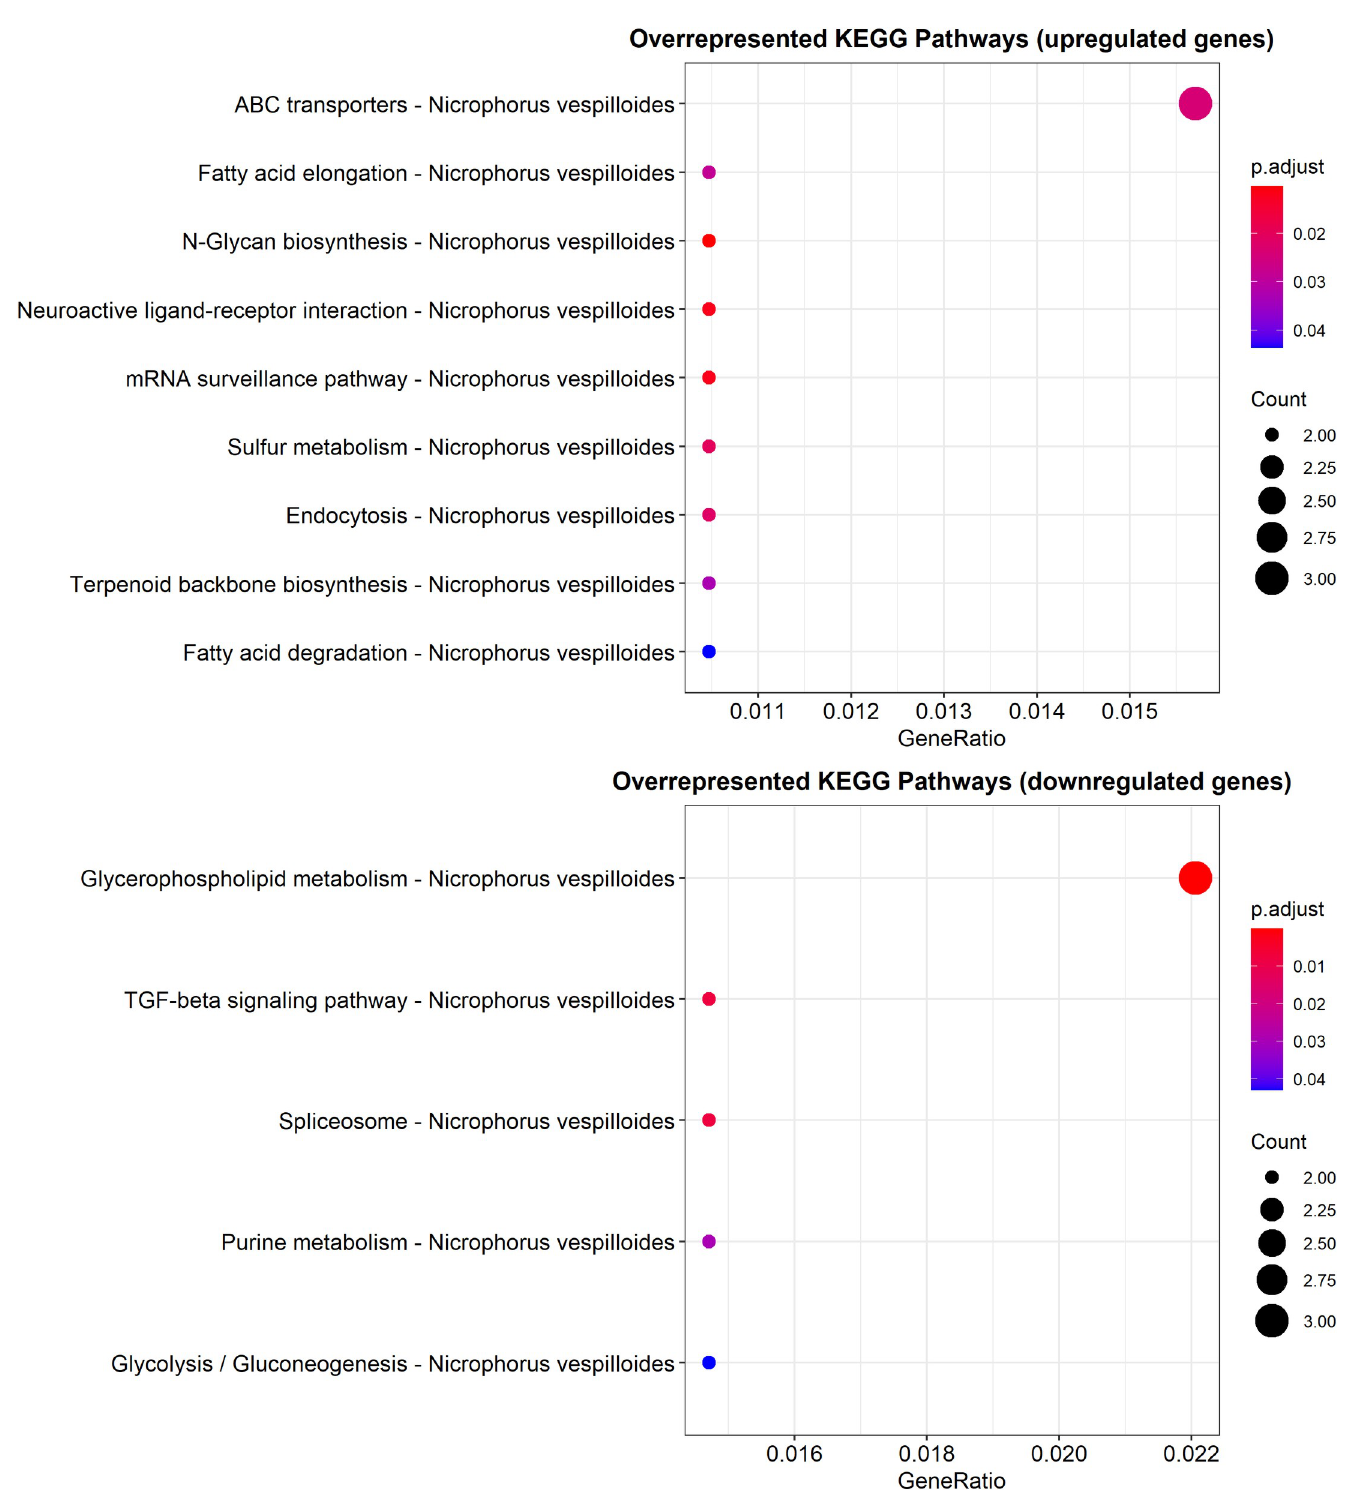
Fig 6. Enriched KEGG Pathways in the DEGs.